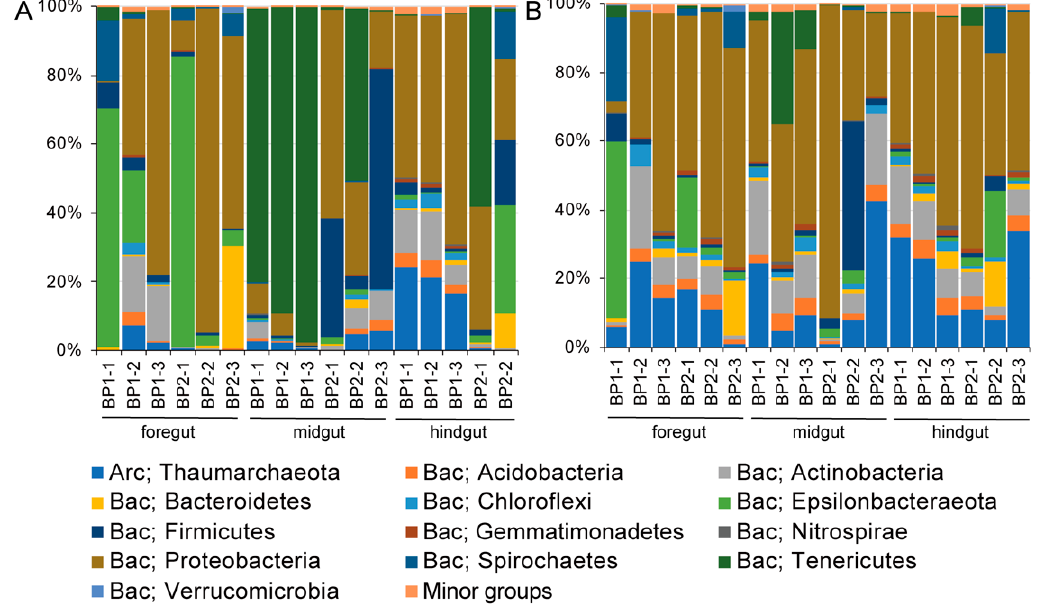
Figure 1. The bacterial composition in ( A ) the intestine and ( B ) its content of Molpadia musculus . The amplicon sequence variants (ASVs) are classified at the phylum level. BP1 and BP2 indicate two sampling sites in the Bay of Plenty. There are three individuals for each site. The hindgut of BP2-3 sample failed to amplify the 16S rRNA gene fragments. A phylum with a percentage less than 1% is classified into minor groups. Bac, Bacteria; Arc,